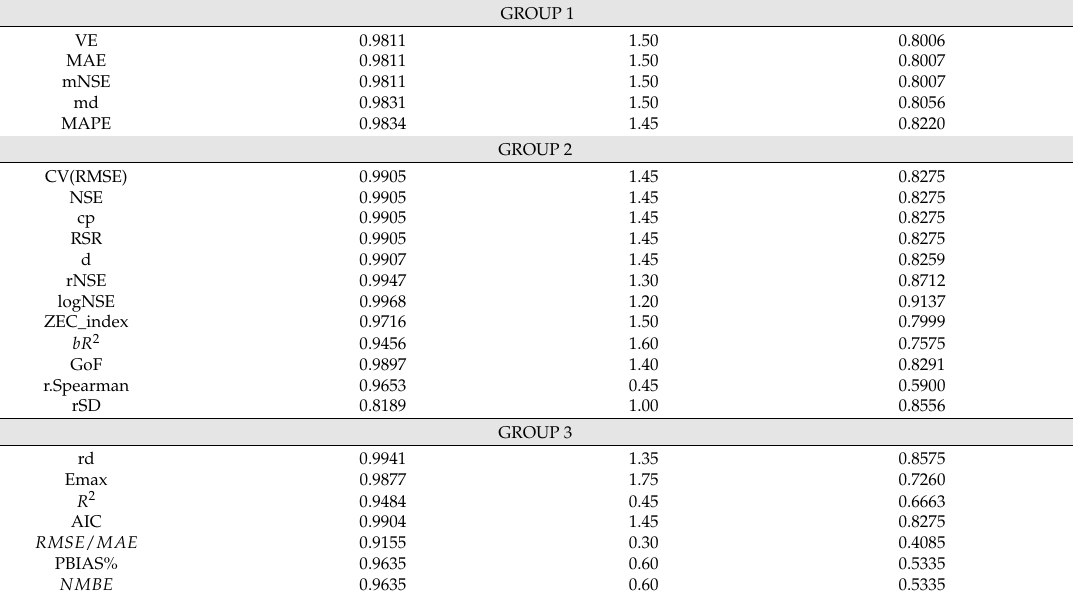
Table 8. (Real case) Group index segmentation by the λ value where the uncertainty indices calculated on weighted mean temperatures and p − f actor ( λ ) reach the maximum correlation, in absolute value. The calculated p -values for these correlations are above 0.95 in most case. The considered λ values were taken within interval [0.05,